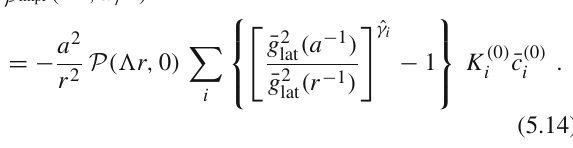
and normalize 0